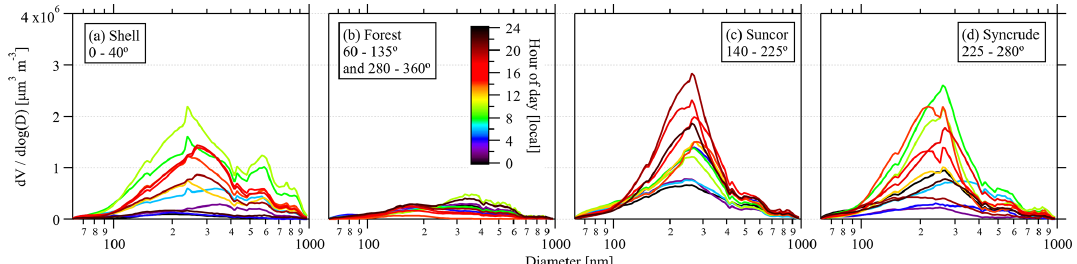
Figure 4. Volume particle size distributions (PSDs) by time of day (averaged over 2h) for the four sectors identified in Fig. 2 (with the two forest sectors